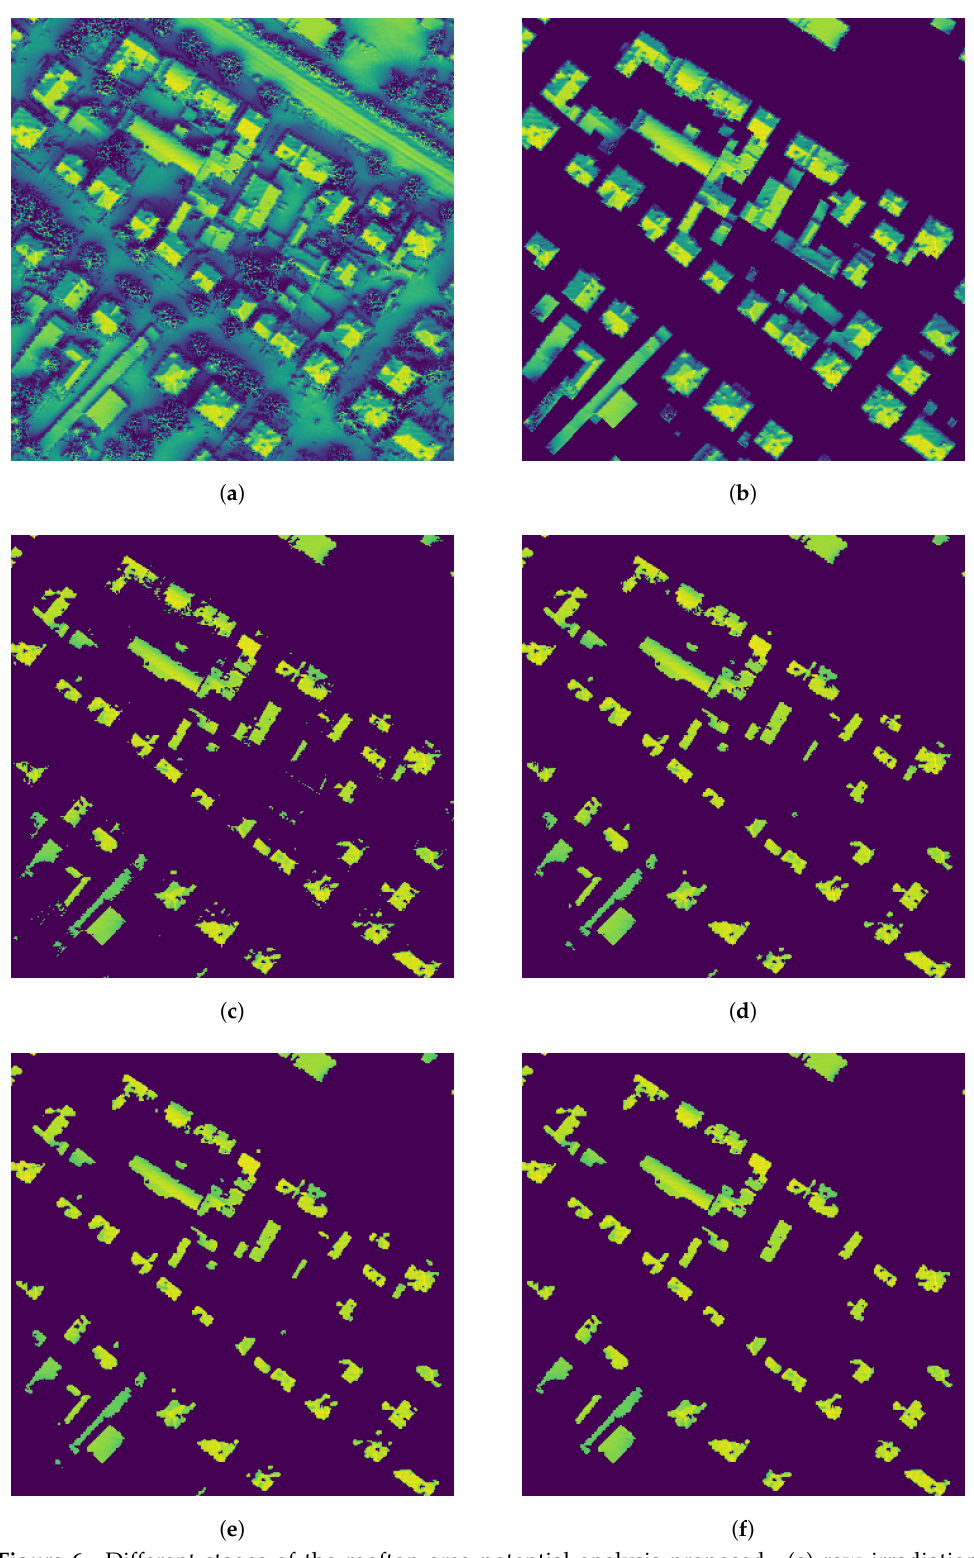
Figure 6. Different stages of the rooftop area potential analysis proposed. ( a ) raw irradiation data input. ( b ) irradiation data cropped to building footprints. ( c ) irradiation data after applying irradiation cutoff value. ( d ) irradiation data after application of the M OORE filter. ( e ) irradiation data after application of the V ON N EUMANN filter. ( f ) Resulting irradiation layer after omitting small raster